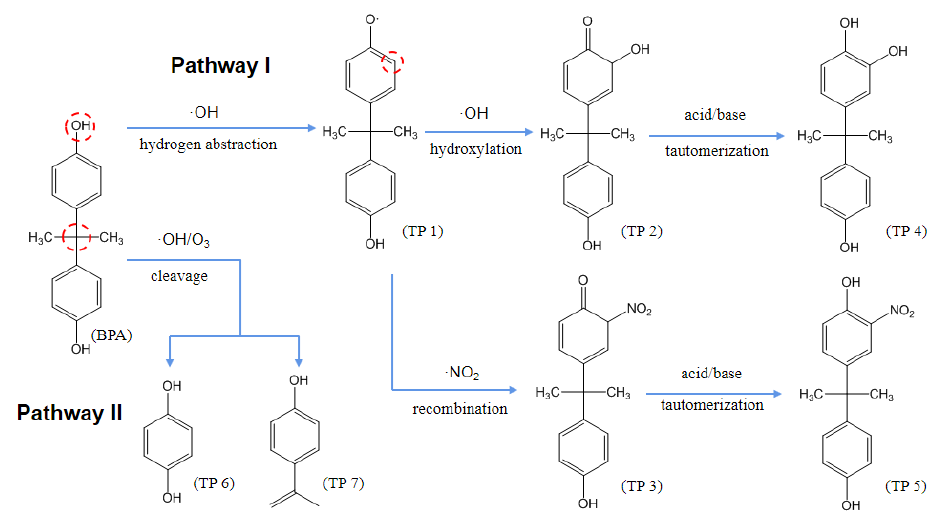
Figure 3. The proposed BPA degradation